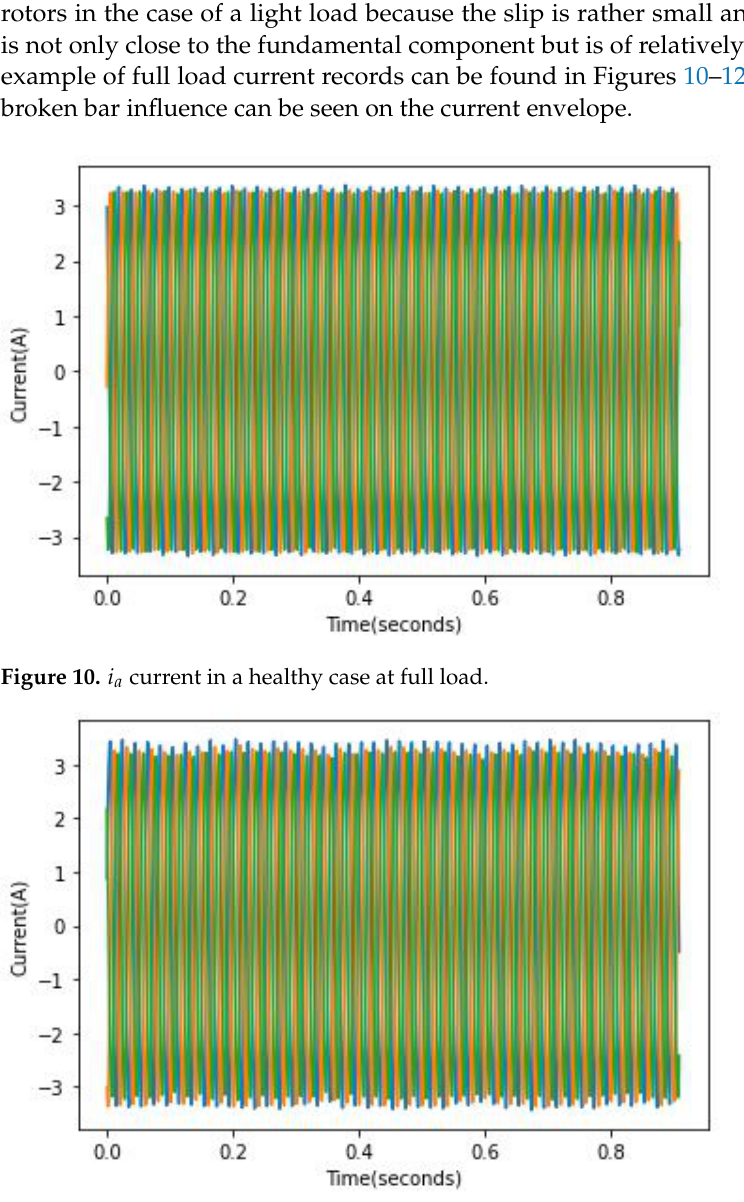
Figure 11. i a current in 1 BRB